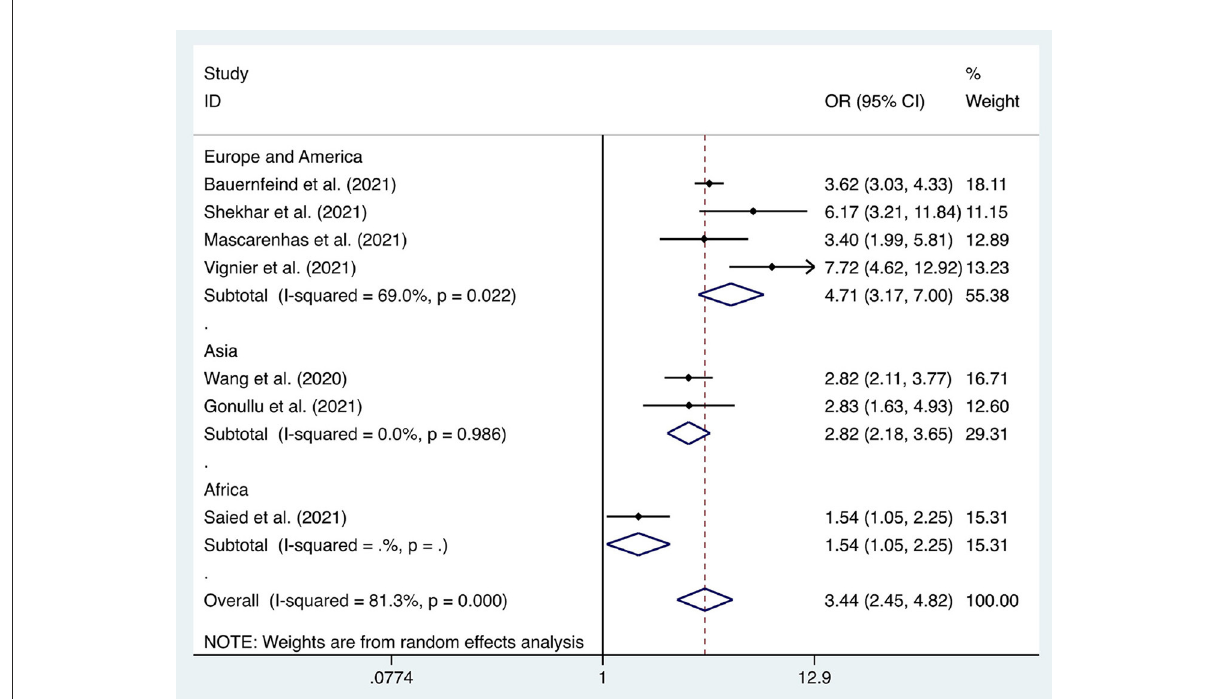
FIGURE8 Forest plot of the acceptance of seasonal influenza vaccines by healthcare workers (2019–2020).